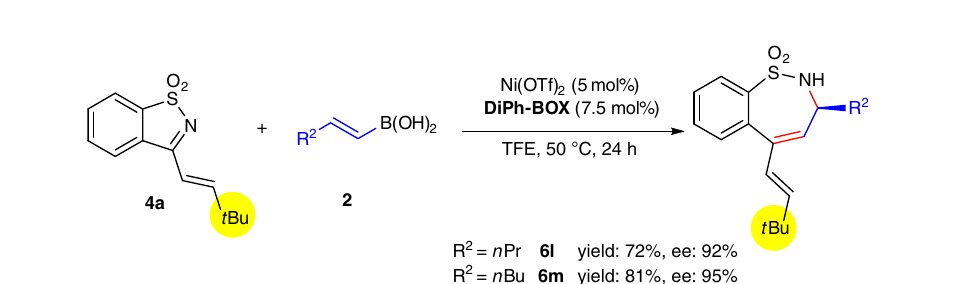
Fig. 2 Sterically-controlled site-selective asymmetric alkenylation/ring-expansion of ketimine 4a . The results using linear alkyl-substituted vinylboronic acids as nucleophiles reaction with 4a indicate that the asymmetric alkenylation/ring-expansion can also be controlled by steric